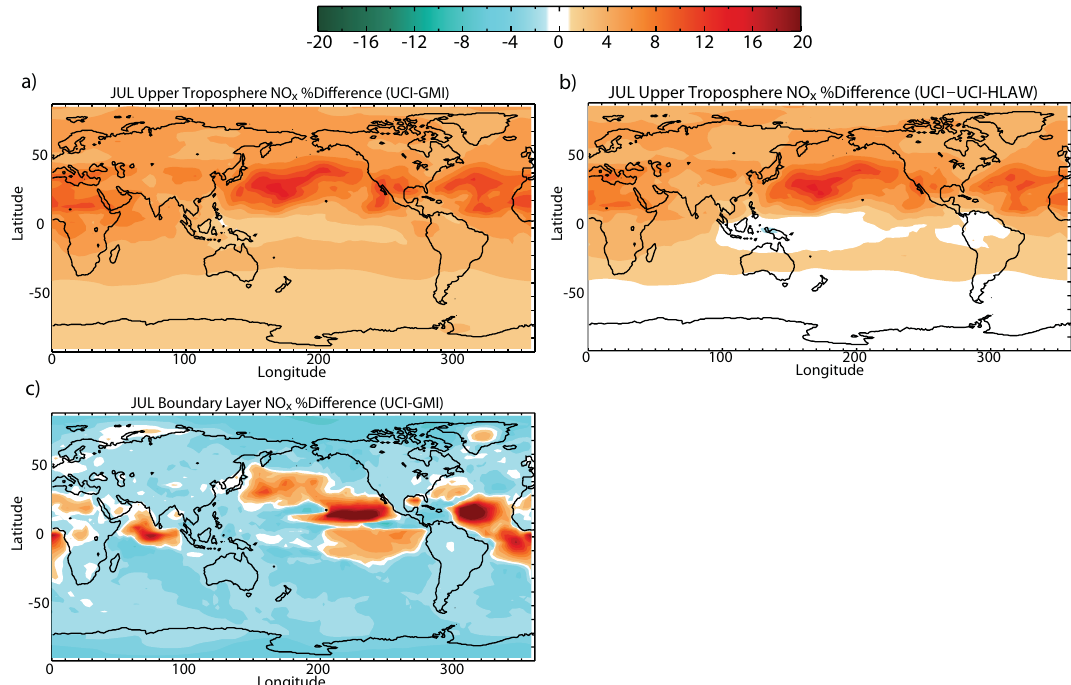
Fig. 4. (a) Latitude-longitude cross section of the percent difference between UCI and GMI (UCI-GMI/UCI) NO x averaged over the upper troposphere (150hPa <p < 500hPa) for July. Contour range is − 20 to 20%. (b) Same as (a) but for the percent difference between UCI and UCI-HLAW. (c) Same as (a) , but NO x is averaged over the boundary layer ( p > 850hPa).